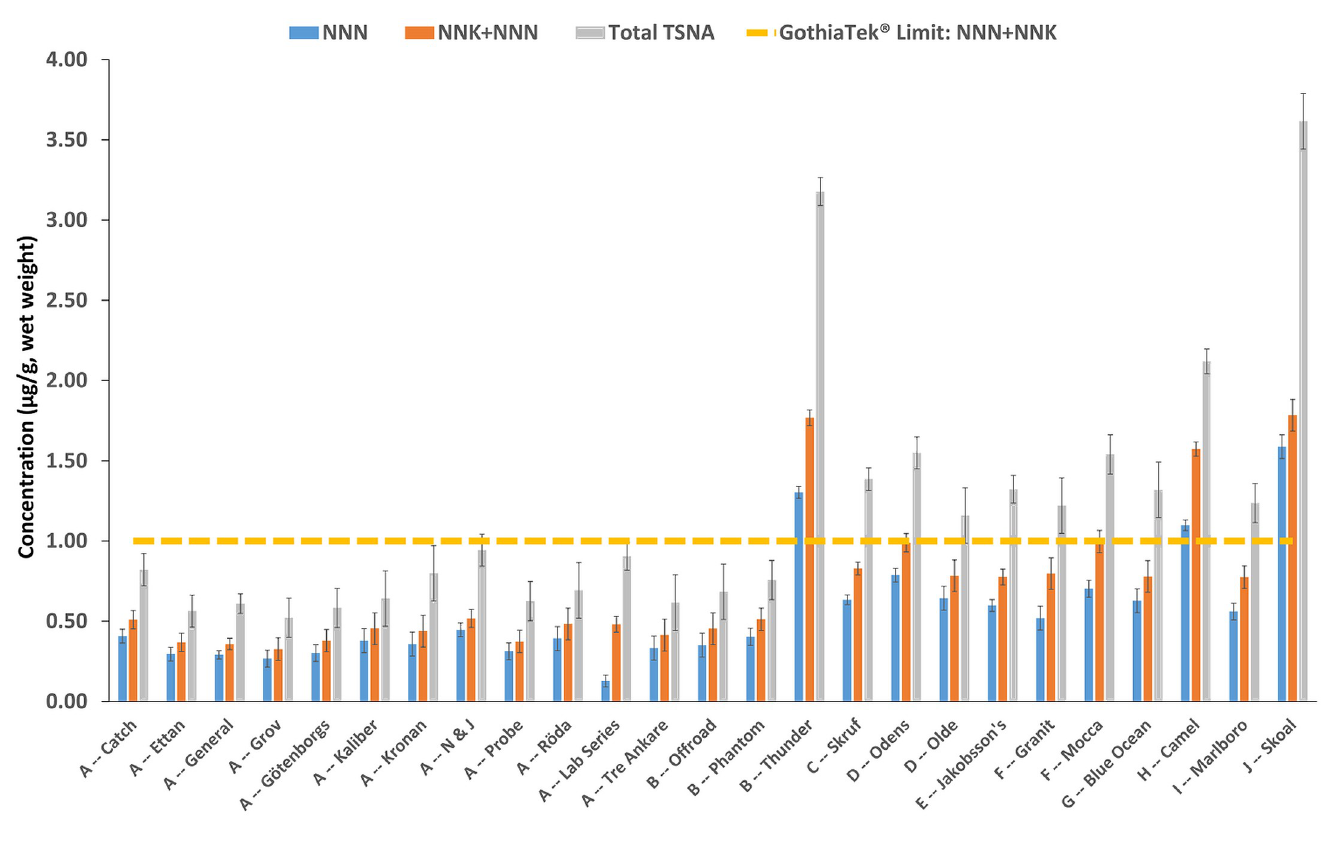
Fig 4. Arithmetic means comparing TSNA concentrations in snus by brand family (n = 25) and manufacturer in Europe [A-G] and the US [H-J]). Only products made by manufacturer A appears to conform to the GothiaTek 1 quality standard. All concentrations are expressed as micrograms per gram ( μ g/g) product (wet weight basis). Note. A-J represent the different manufacturers: A) Swedish Match, B) V2 Tobacco, C) Imperial Tobacco Group, D) GN Tobacco Sweden AB, E) Gotland Snus AB, F) British American Tobacco, G) AG Snus, H) RJ Reynolds, I) Philip Morris, and J) U.S. Tobacco Company. Arithmetic means and standard errors are estimates from 10,000 bootstrap resamples of the data. Error bars represent bootstrapped standard errors.